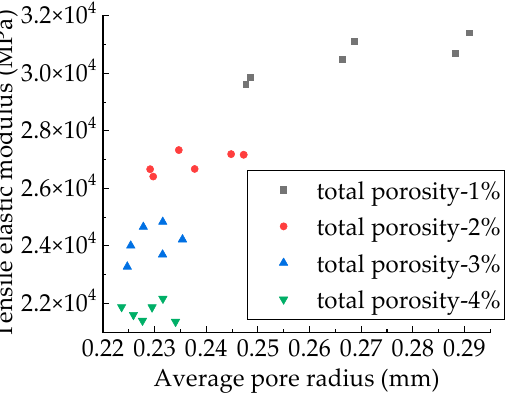
Figure 17. Relationship between average pore radius and elastic modulus.